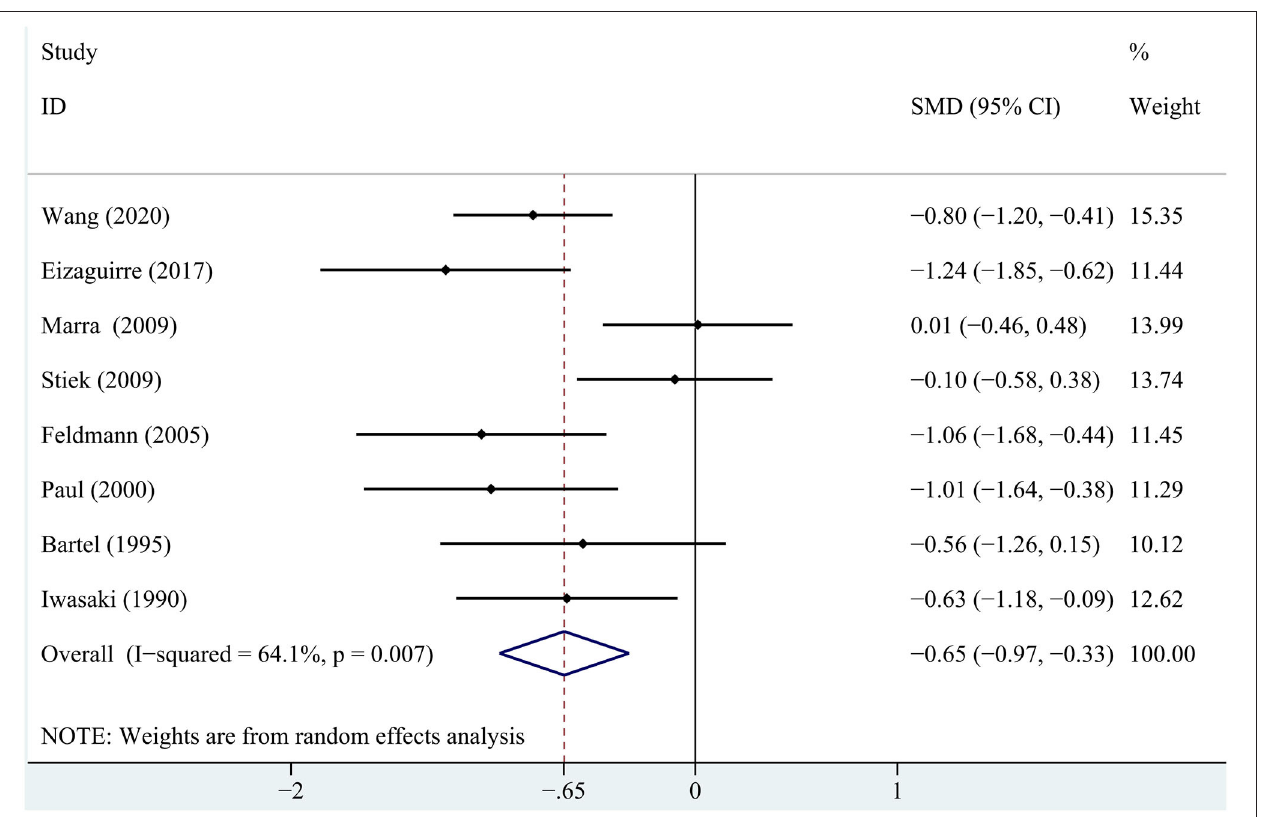
FIGURE 2 | A forest plot of the association between myasthenia gravis (MG) and immediate recall